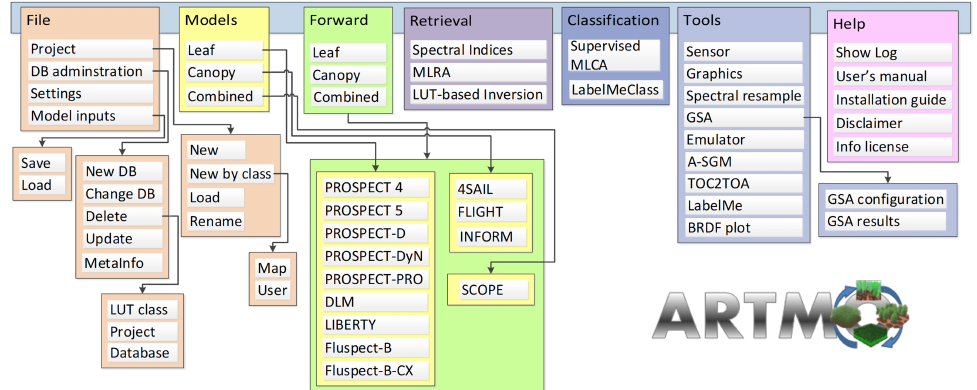
Figure 1. Schematic overview of ARTMO’s v3.29 modules (RTMs, toolboxes,